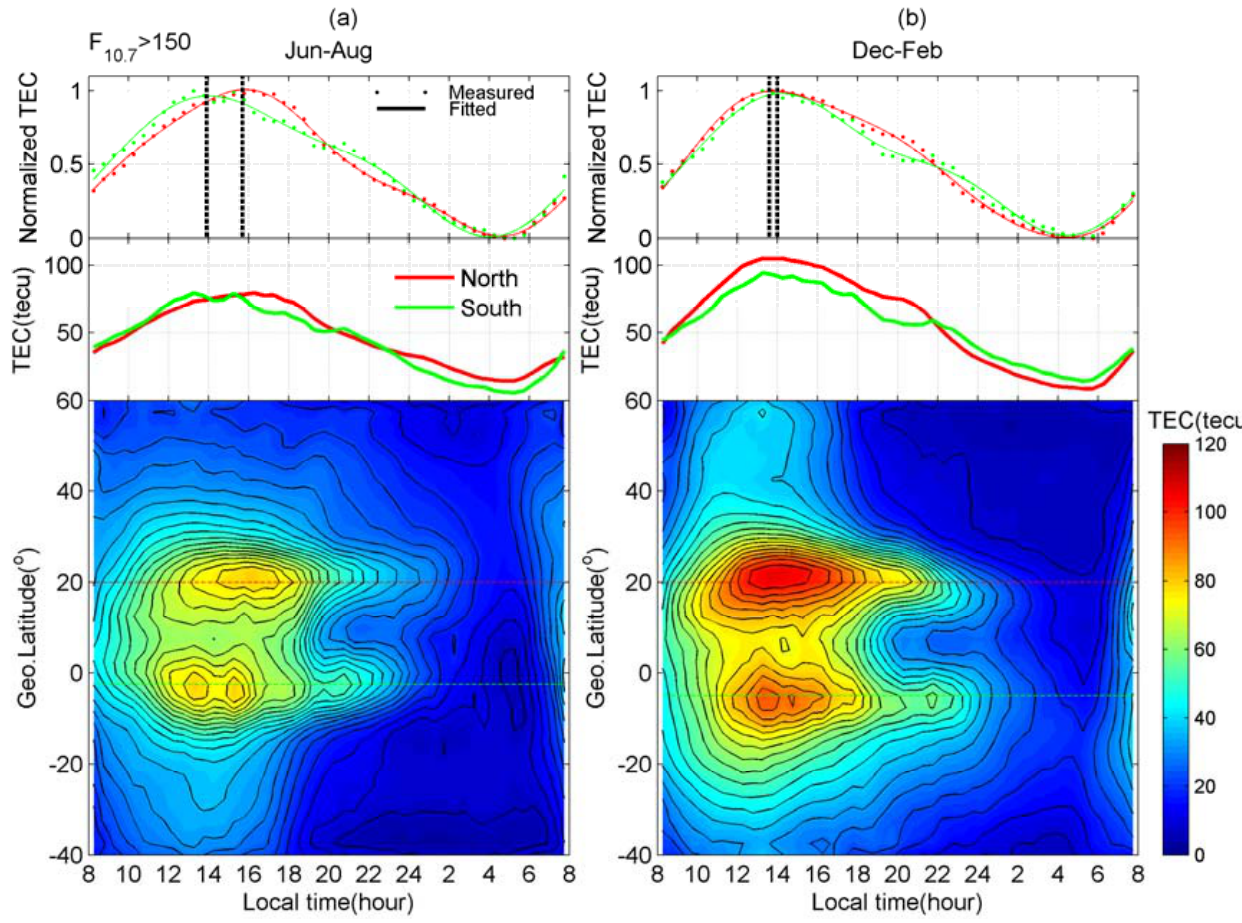
Fig. 5. Mean variation of EIA during June–August (left) and December–February (right) under the condition F 10 . 7 > 150 (bottom panels). The horizontal line indicates where the most developed EIA crest is, both for northern (red) and southern (green) one. The middle panels show the diurnal variation of the crests. The top panels illustrate the time difference of the appearance of peak value for the normalized diurnal variation. The dots represent the measured value and the lines the fitted.